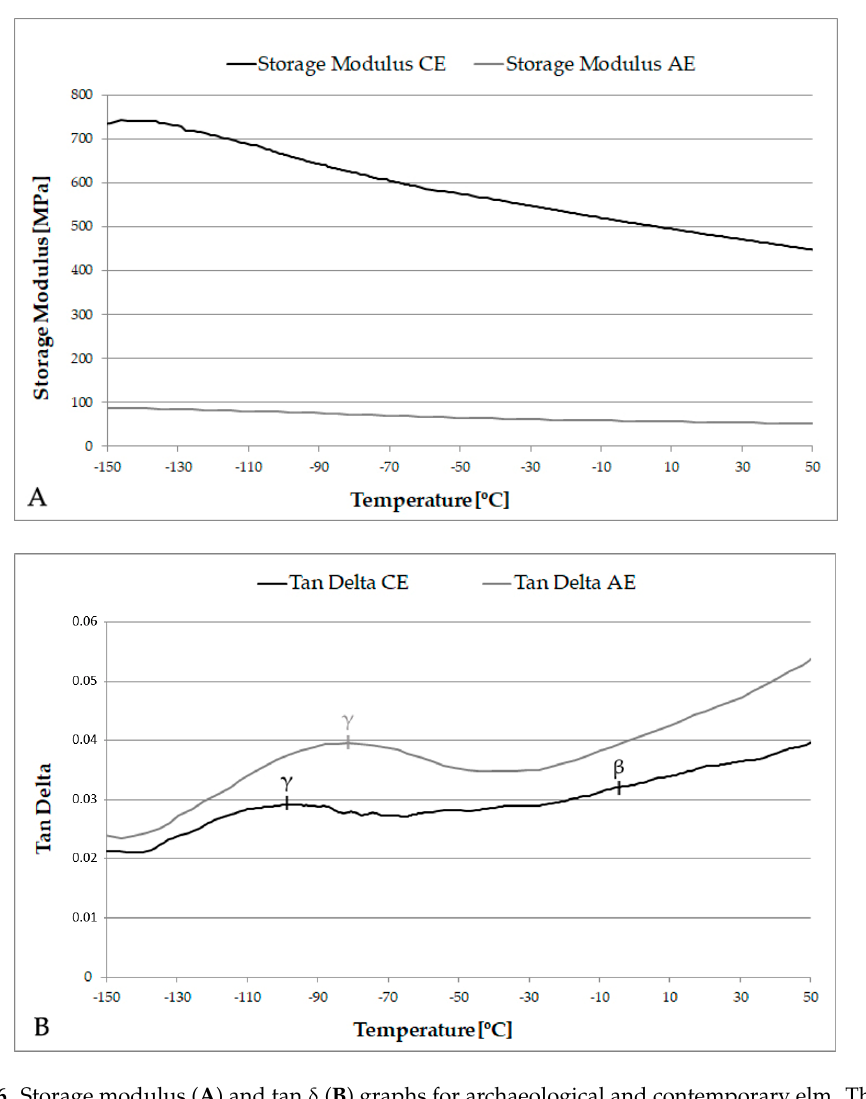
Figure 6. Storage modulus ( A ) and tan δ ( B ) graphs for archaeological and contemporary elm. The line at 40 °C indicates the temperature above which transient moisture effects may influence observations of damping.